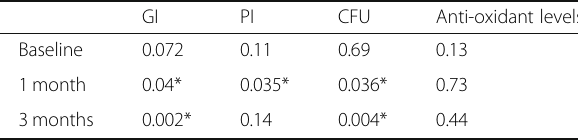
Table 4 Intergroup comparison of statistically significant results using Post hoc using Mann-whitney